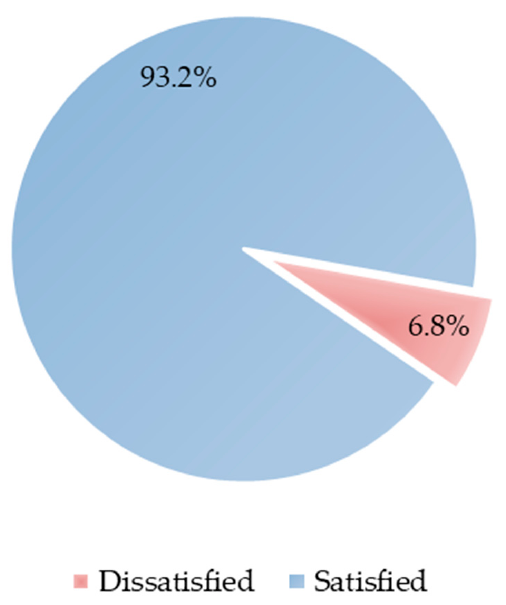
Figure 1. Patients’ Satisfaction vs Dissatisfaction with outreach health services. Further, the findings from the bivariate associations between potential covariates and patients’ satisfaction with outreach clinics are portrayed in Table 2. The compar- isons between the participants’ satisfaction and dissatisfaction with the outreach services showed that satisfaction significantly differs by type of transport ( p < 0.05), frequency of visits ( p < 0.05) and the experience of being treated by health professionals with respect ( p < 0.001). Table 2. Bivariate association between sociodemographic factors and patients’ level of satisfaction.